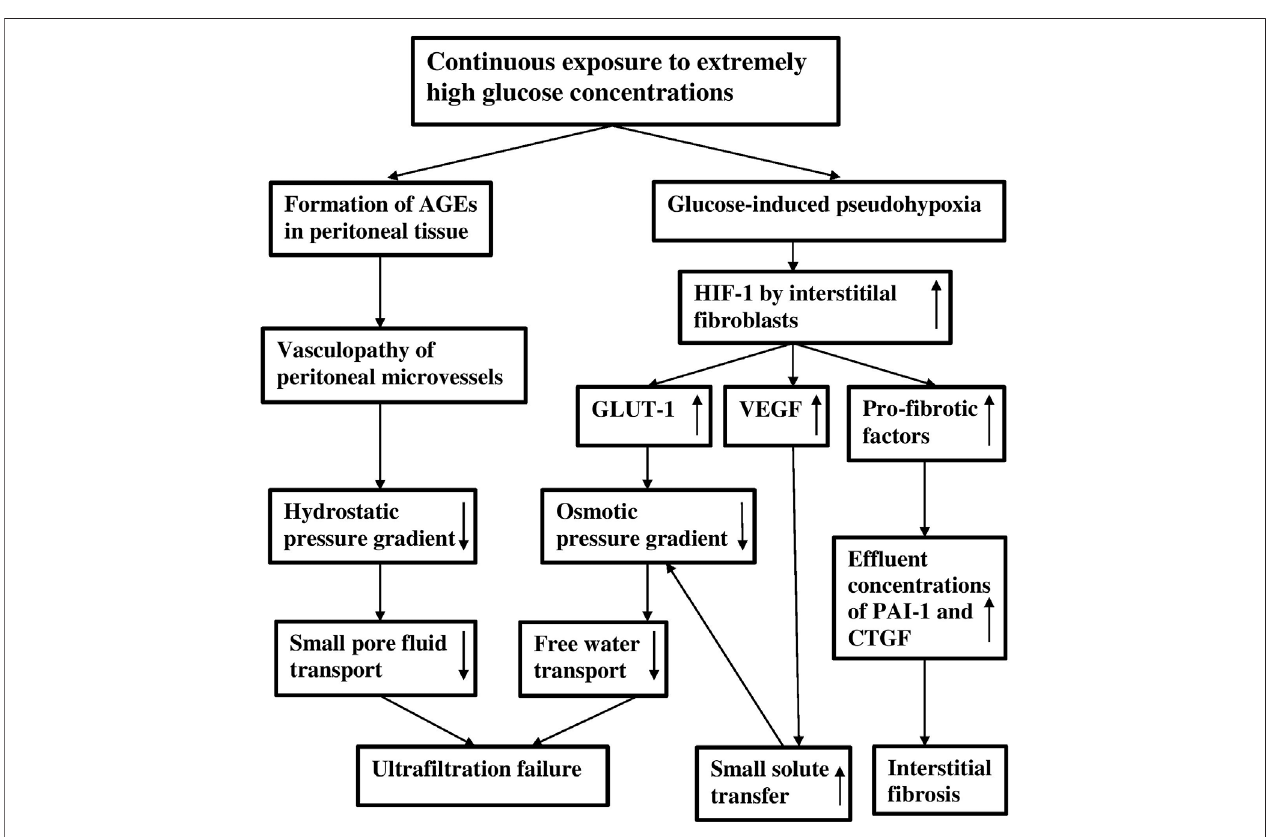
FIGURE 3| Ascheme ofthe effects ofcontinuousexposureto extremely high glucose concentrationson theperitoneal dialysis membrane. Note that ultra fi ltration failure can be caused by a vasculopathy-induced decreased hydrostatic pressure gradient and by a decreased osmotic pressure gradient, due to increased GLUT-1 expression and to increased small solute transfer. The low osmotic pressure gradient causes a reduction of free water transport.